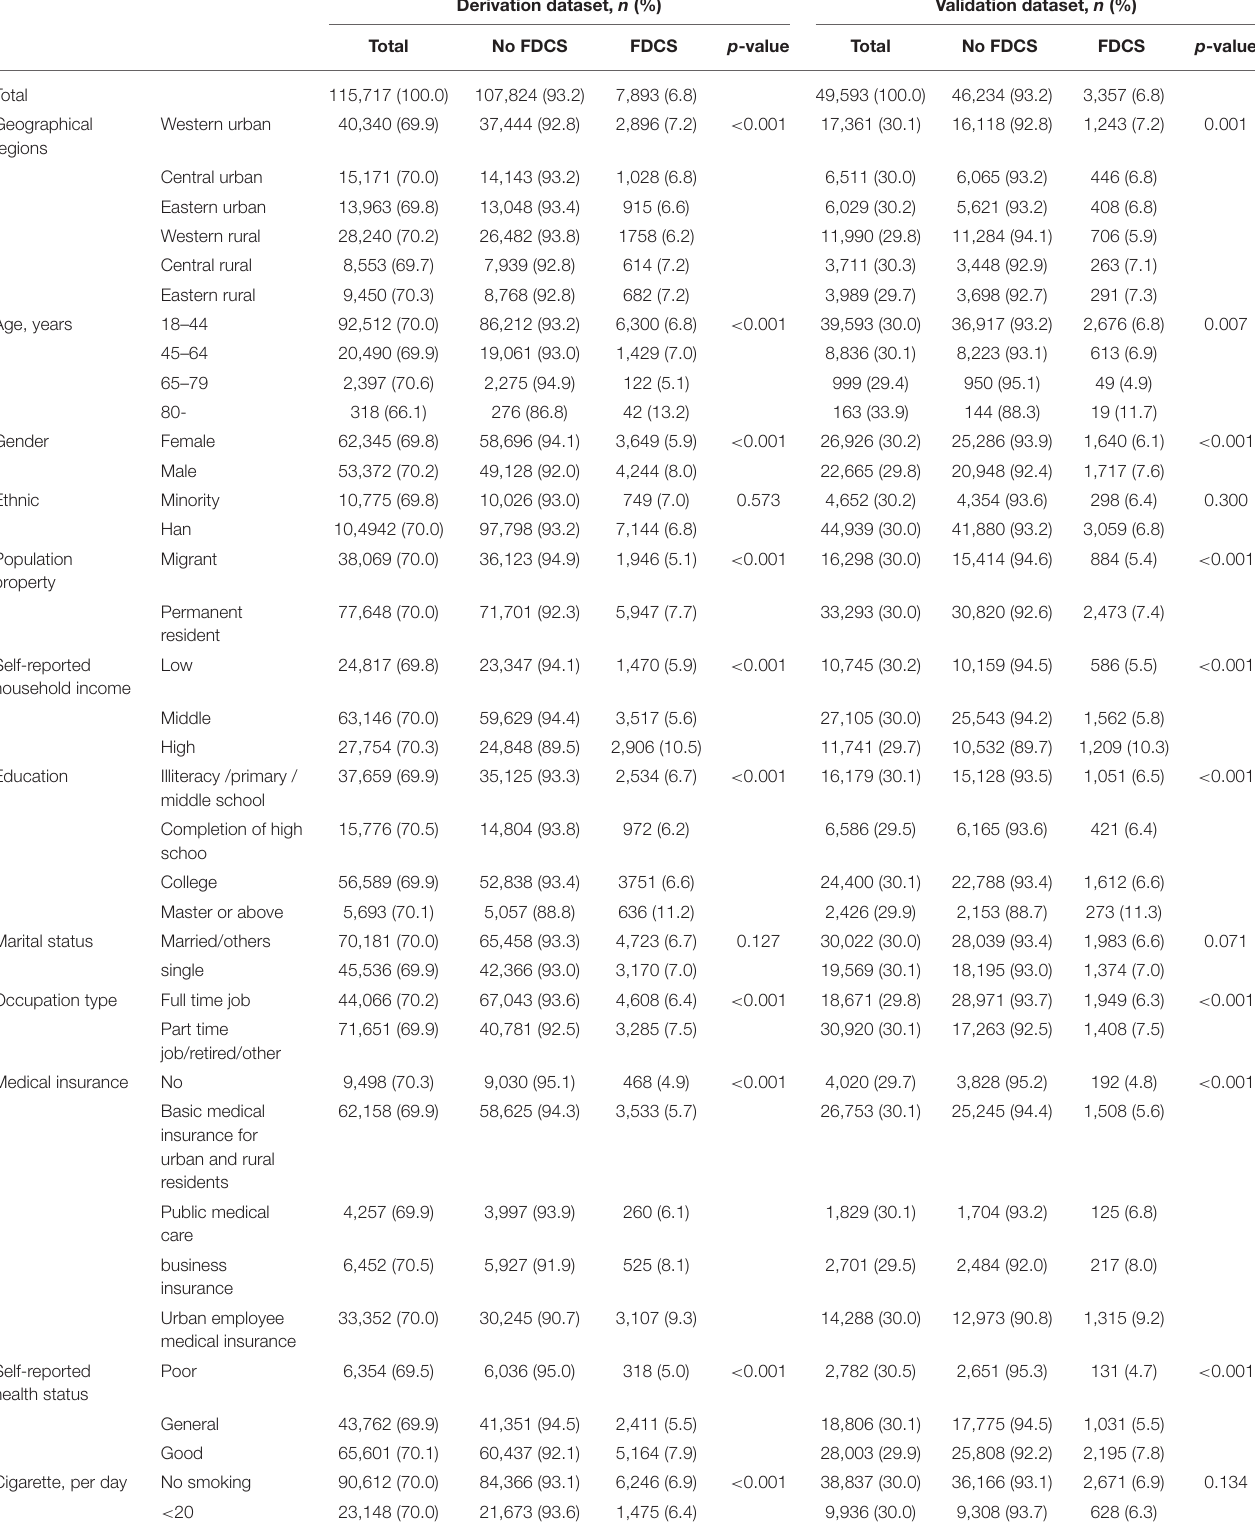
TABLE 1 | Baseline characteristics of the derivation dataset and validation